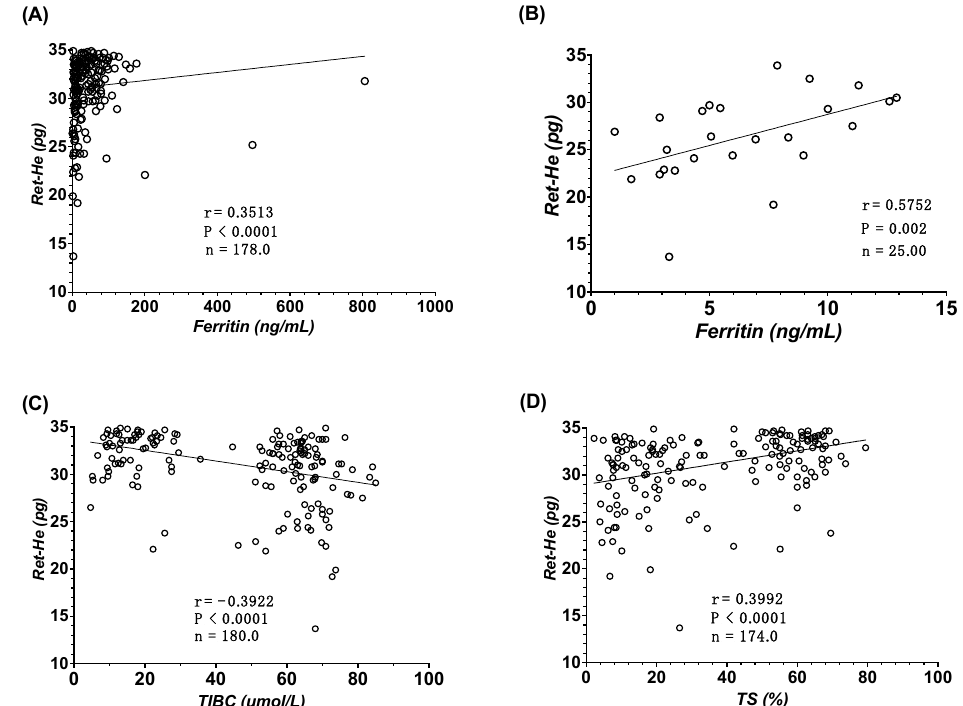
Figure 3. Correlation between reticulocyte hemoglobin equivalent (RET-He) and parameters of iron metabolism. ( A ) Correlation between RET-He and ferritin, ( B ) correlation between RET-He and ferritin < 13.0 ng/mL. ( C ) Correlation between RET-He and total iron binding capacity (TIBC), and ( D ) correlation between RET-He and transferrin saturation (TS).